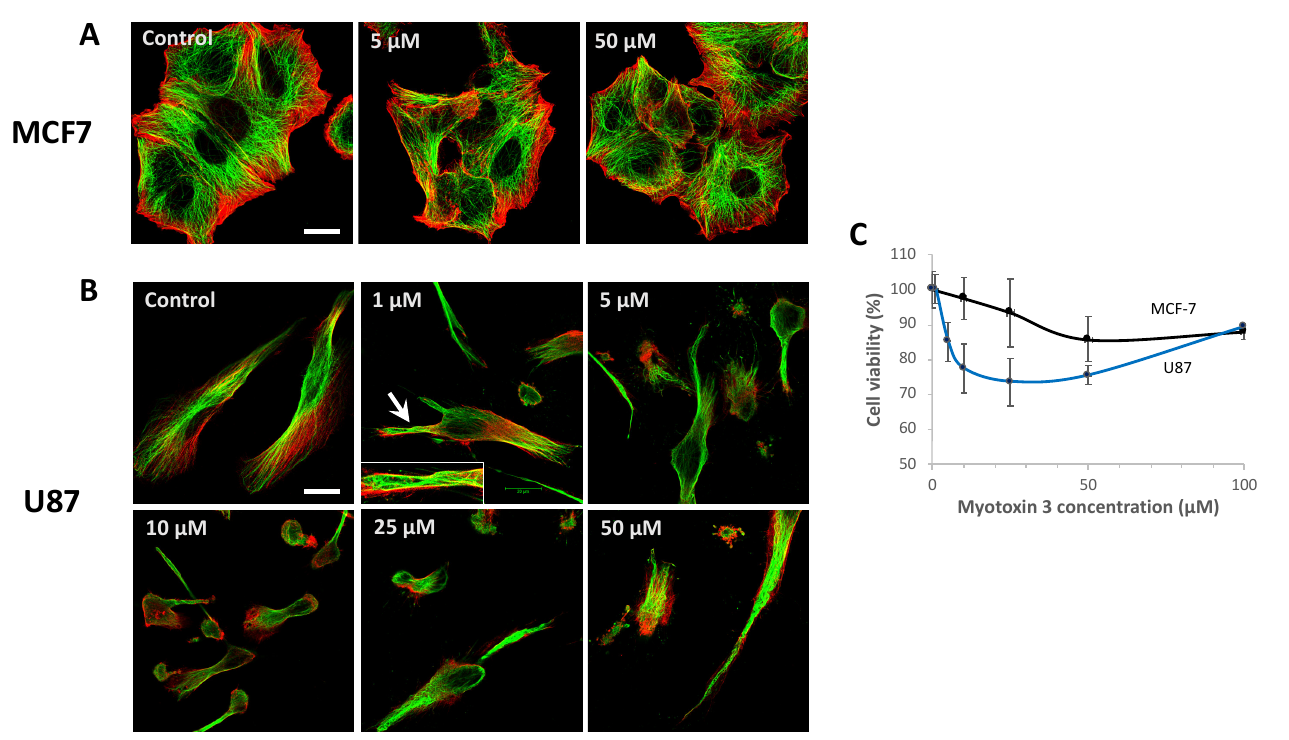
Figure 9. Microtubules and actin fibers labeling in MCF-7 and U87 cells. MCF-7 ( A ) and U87 ( B ) cells were treated for 24 h with the indicated concentration of myotoxin-3. Cells were then fixated, and actin fibers were labeled with phalloidin-TRITC (red) and microtubule network with anti-α-tubulin antibody (green). The arrow shows microtubules organized in wavy bundles (magnified in the inset). Bars = 20 µm. ( C ) The viability of MCF-7 and U87 cells was assessed by MTT after incubation with myotoxin 3 for 24 h at 37 °C. Data are from a representative experiment of two performed in triplicate.